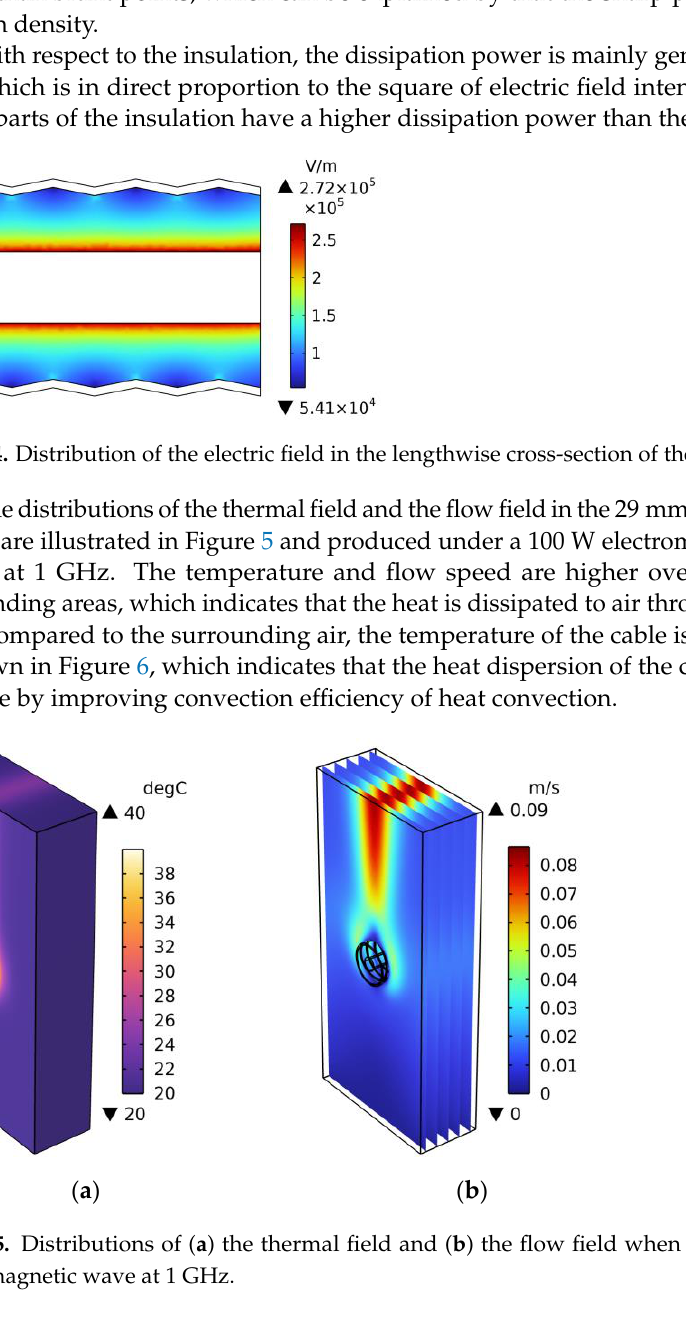
Figure 6. Distribution of the temperature of the cable. The displacement of every particle of the cable is shown as Figure 7, produced under a 100 W electromagnetic wave transmitted at 1 GHz. Due to the difference of the thermal expansion coefficient, the conductors and the insulation have quite different displacements. In fact, the corrugated outer conductor alleviates the expansion of the insulation and also amplifies the stretch of the conductors. Moreover, if the structure parameters of the outer cable are fit such that the expansion of the cable compensates the effect of the temperature variation on phase stability better, the thermal phase stability of the cable would be enhanced.